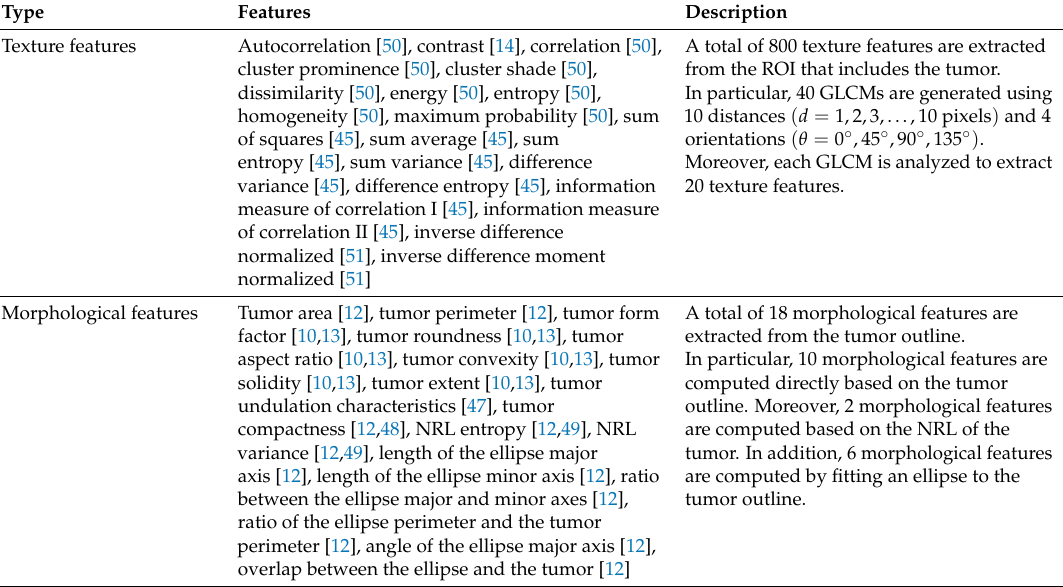
Table 2. The handcrafted texture and morphological features that are extracted from the BUS